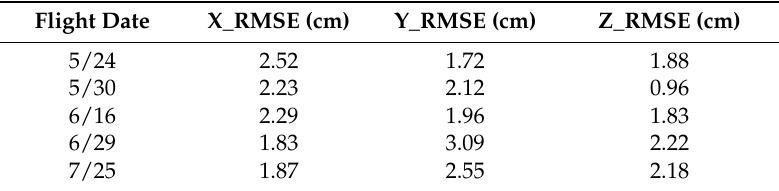
Table 6. RMSE at GCP locations for the SfM model over five